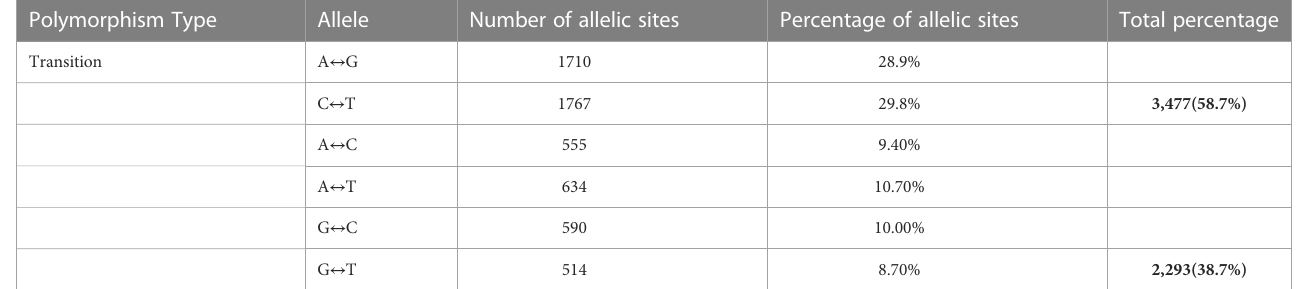
TABLE 4 Degree of transition and transversion identi fi ed using